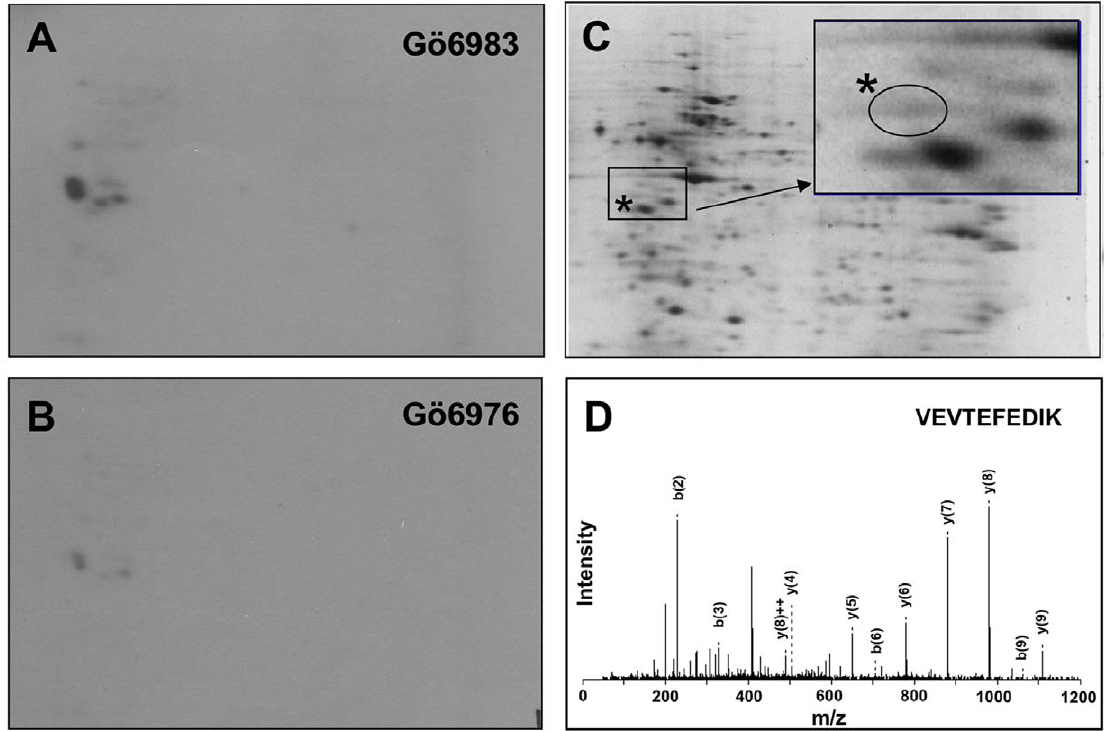
Figure 1. SET protein in Jurkat nuclear extract is phosphorylated by PKD2. Activated PKD2 was immunoprecipitated from lysate of Jurkat cells stimulated with anti-CD3 e antibody. The heat-inactivated (50 u C, 5 min) Jurkat nuclear extract was used as a substrate for PKD2 and analyzed by 2D-gel electrophoresis. (A) Activated PKD2 was incubated with the nuclear extracts in the presence of [ c - 32 P]-ATP and Go¨6983 (an irrelevant PKC inhibitor) and the radioactivity of 2D-electrophregram was detected. (B) Activated PKD2 was incubated with the nuclear extracts in the presence of [ c - 32 P]-ATP and Go¨6976 (PKD2 inhibitor) and the radioactivity of 2D-electrophoregram was detected. (C) The proteins in the Jurkat nuclear extract treated with non-radioactive ATP and PKD2 were stained with syproruby. Inset; the enlarged view of the boxed area. A protein spot indicated by the asterisks, which overlaps to the radioactive spots indicated in A or in B was analyzed by mass spectrometry. (D) One of the MS/MS spectra assigned to be SET protein is shown (m/z=604, 110 VEVTEFEDIK 119